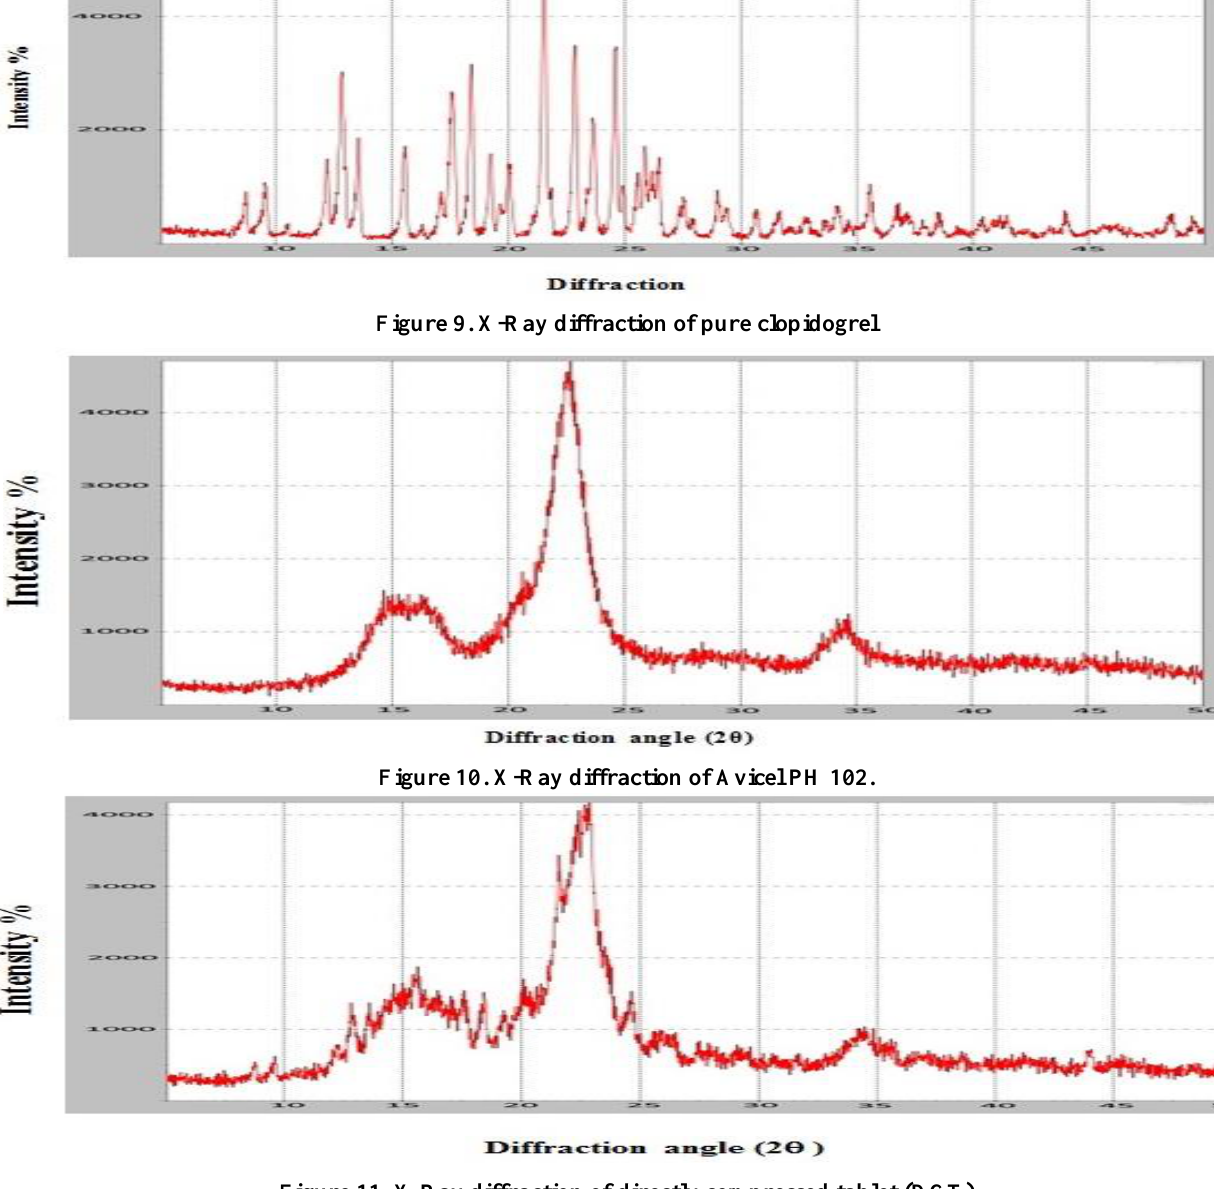
Figure 11. X-Ray diffraction of directly compressed tablet